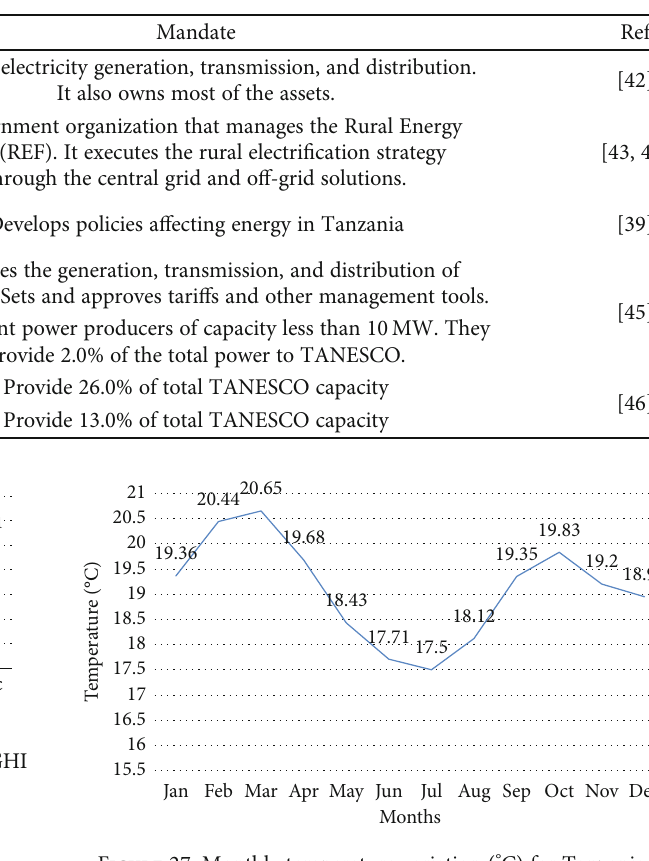
Table 11: Institutions involved in the energy sector in Tanzania.